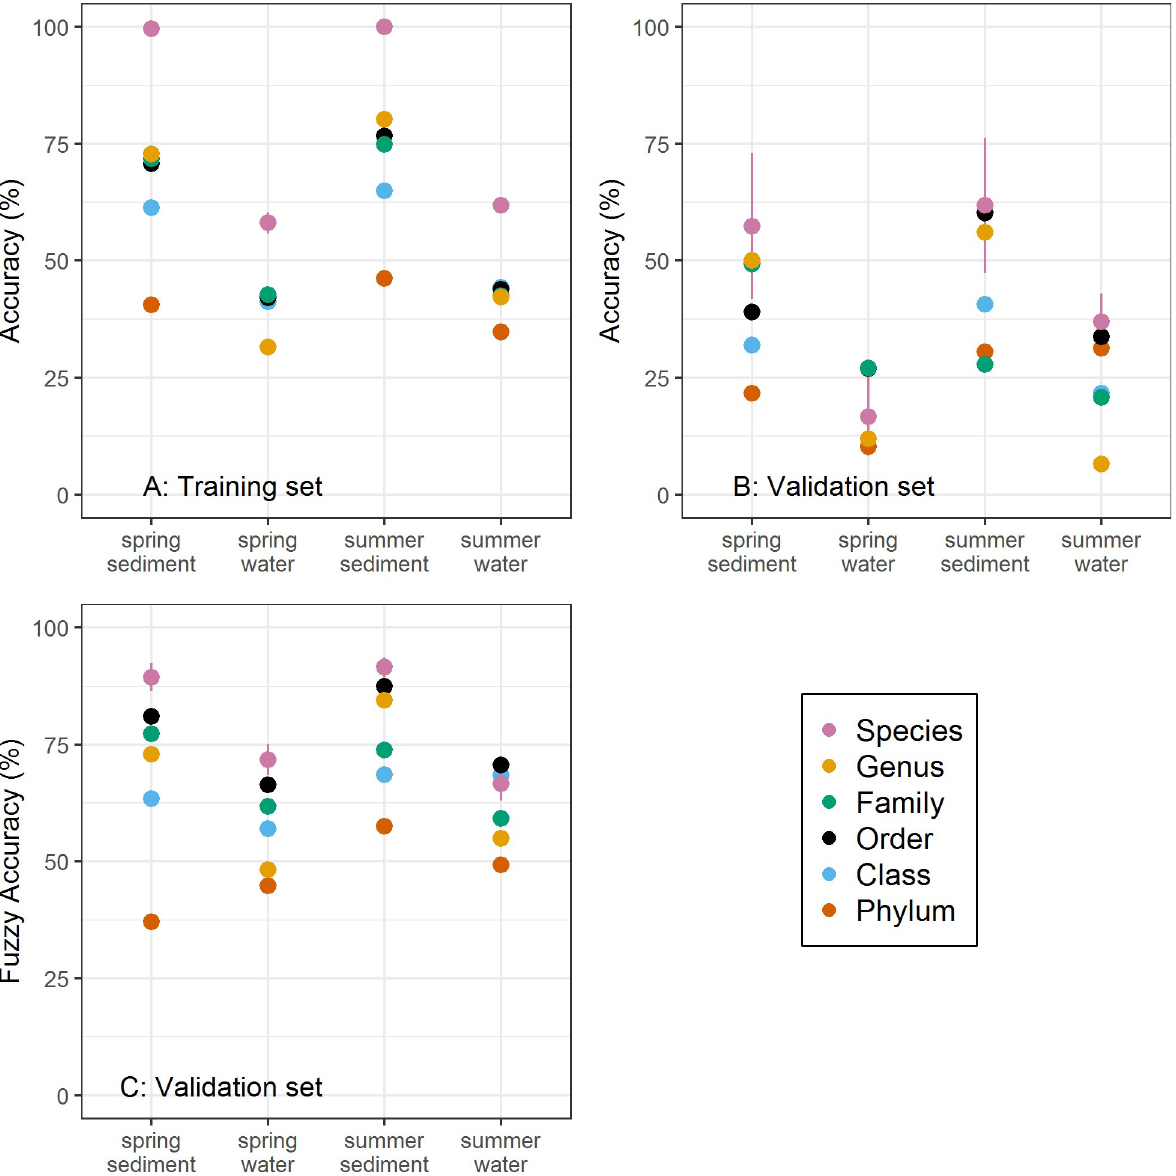
Fig 2. Stream assessment classification accuracy using all taxa. Model classification accuracy of sites into 8 possible BIBI categories for the training dataset (Panel A), validation dataset (Panel B), and the fuzzy classification accuracy for the validation dataset (Panel C) across the differing levels of taxonomic resolution, sampling season (spring, summer), and sampling medium (water, stream sediment). Points represent the mean accuracy across 1,000 model runs resampling 80% of the dataset to form the training dataset and the remaining 20% comprising the validation dataset. Results for species are based on all OTUs, including those not